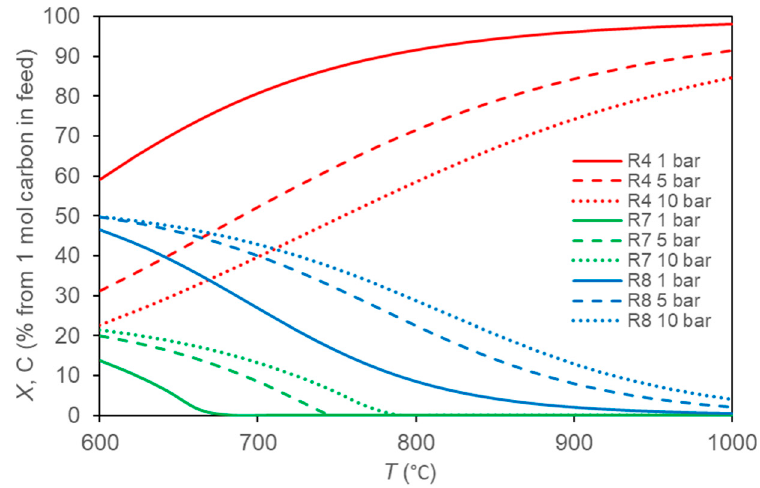
Figure 9. The effect of pressure and temperature on carbon formation from methane decomposition (4), from CO (reverse Boudouard reaction, 7), and from CO and H 2 (reverse gasification reaction, 8). HSC calculation is based on thermodynamic equilibrium. Carbon content in feed set to 1 mol.